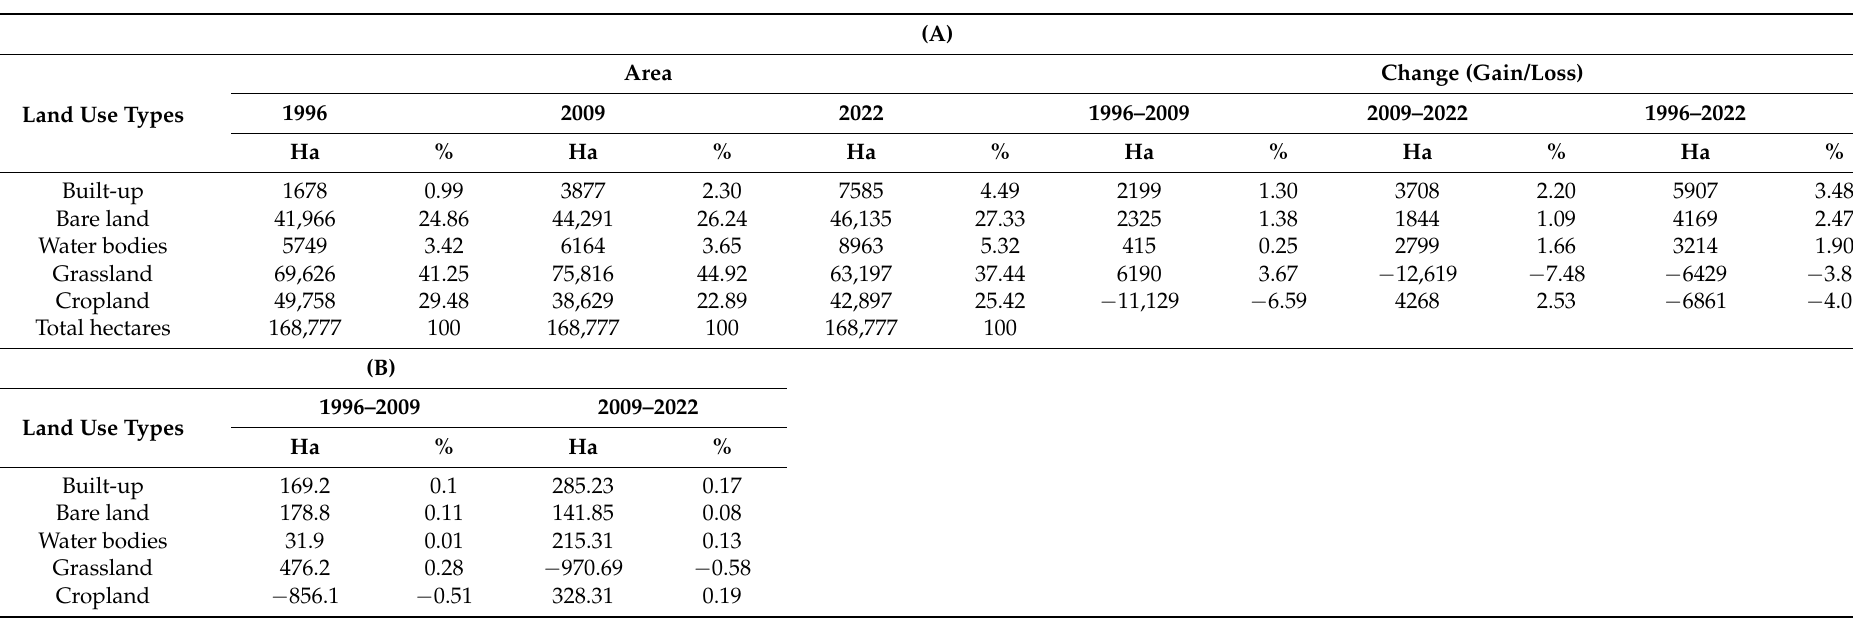
Table 4. ( A ) LULC area coverage, status and changes between 1996, 2009, and 2022. ( B ) Annual rate of change in land cover categories.